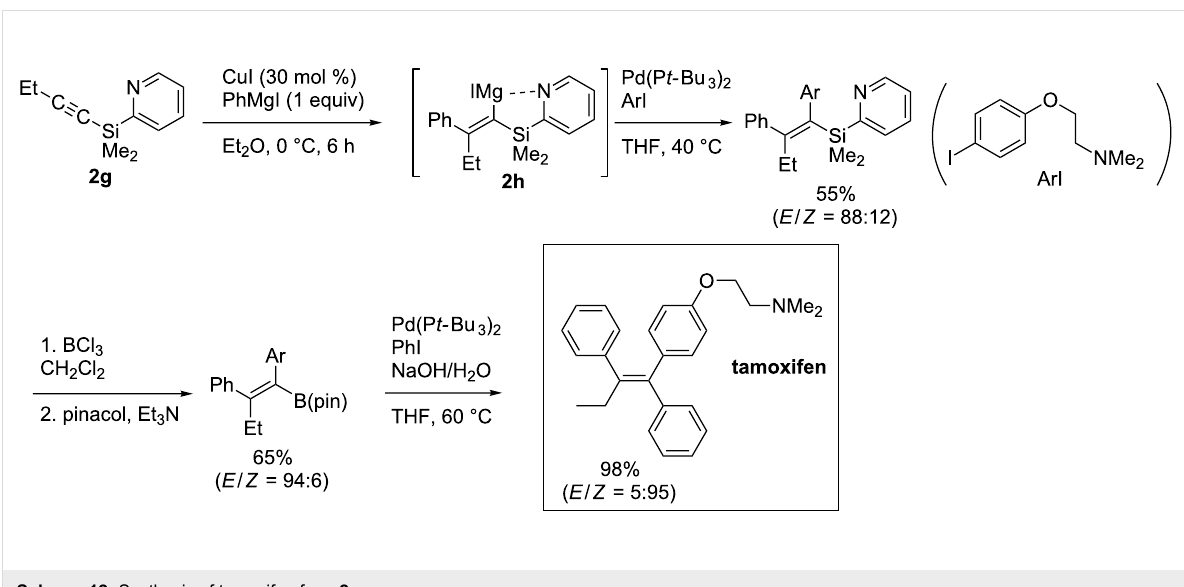
Scheme 12: Synthesis of tamoxifen from 2g